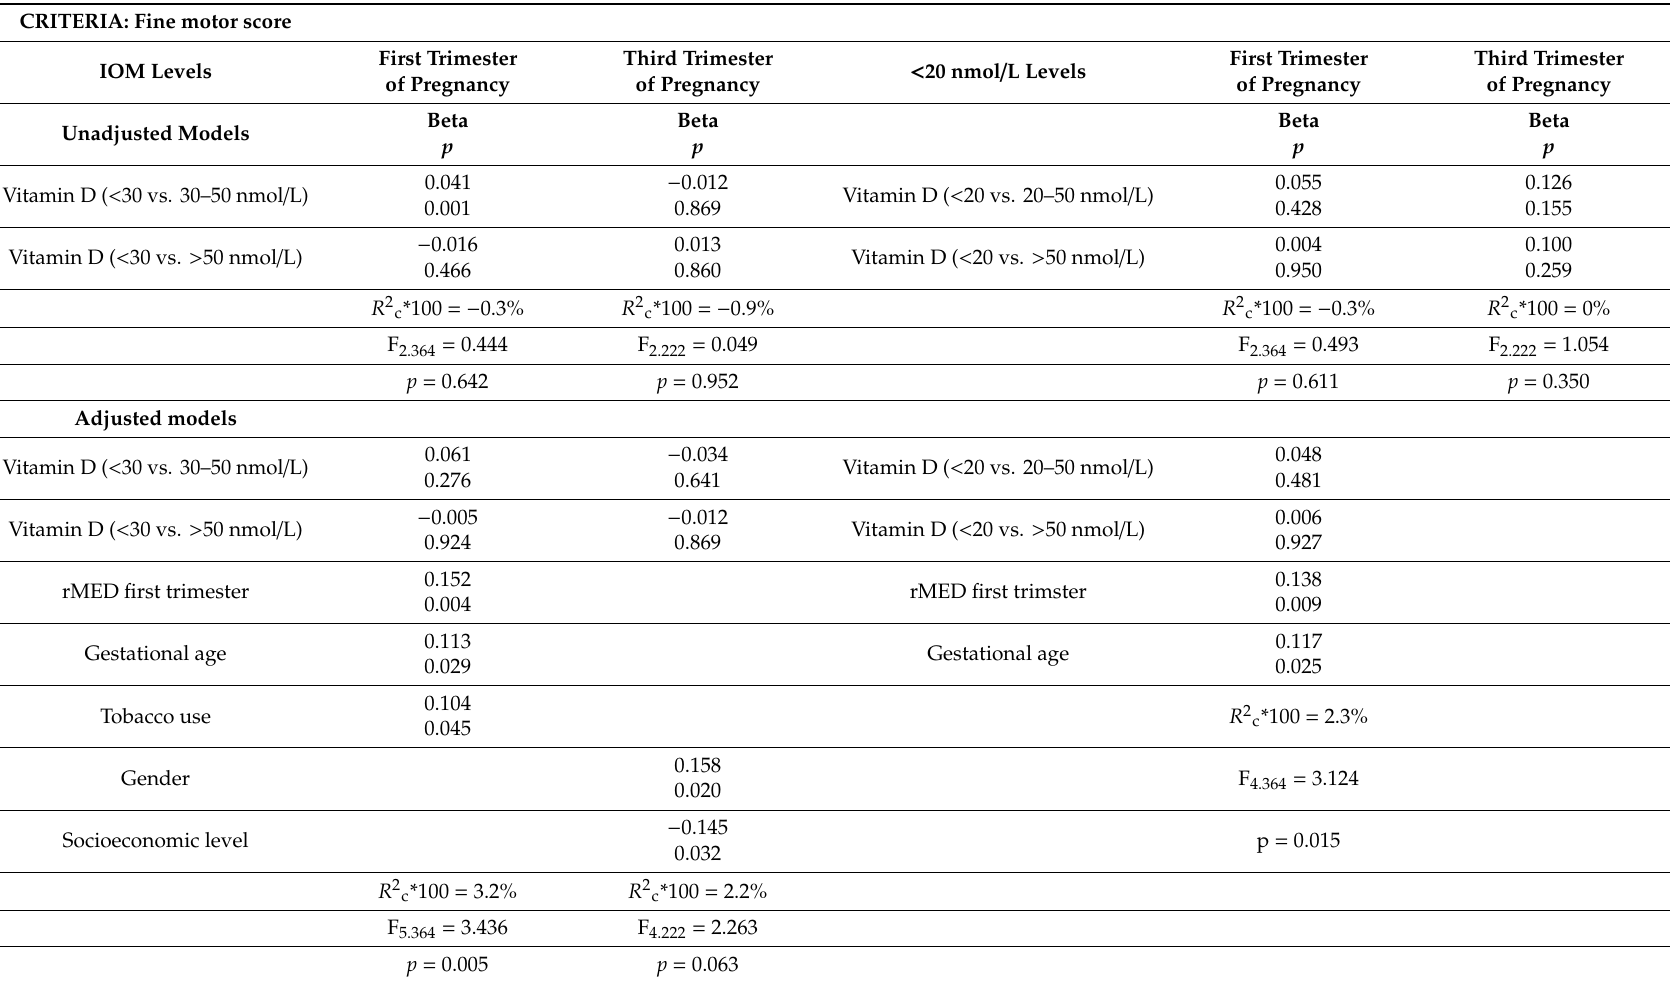
Table 6. Multiple linear regression models to explore the relationship between vitamin D during pregnancy (first and third trimester) and the Bayle Scales of Infant Development-III (BSID-III) motor scores at 40 days